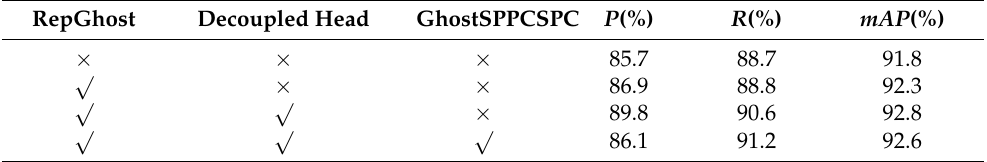
Table 6. Ablation experiment of RepGhost, decoupled head, and